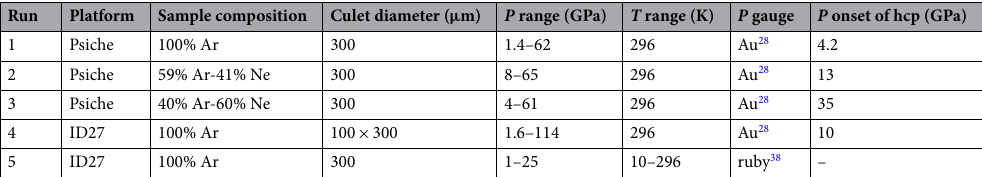
Table 1. Conditions of the experiments. Psiche and and ID27 beamlines are located at Synchrotron Soleil and at European Synchrotron Radiation Facility, France, respectively. Diamond anvils culet diameter is indicated.